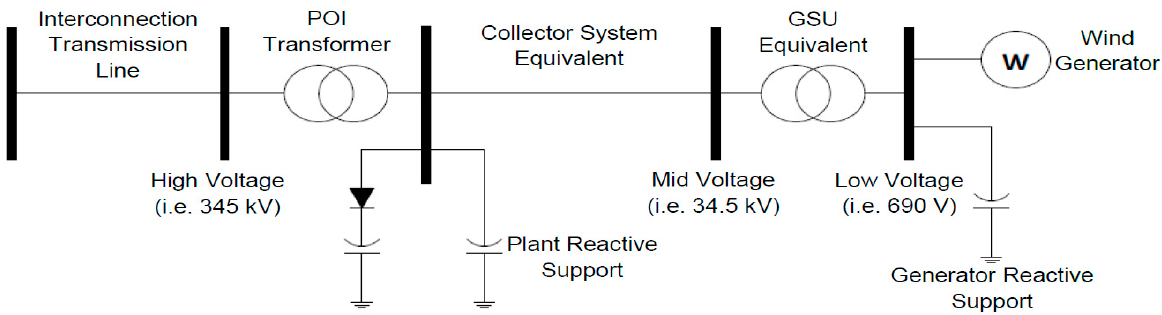
Figure 7. MISO renewable energy equivalent model [9,12].